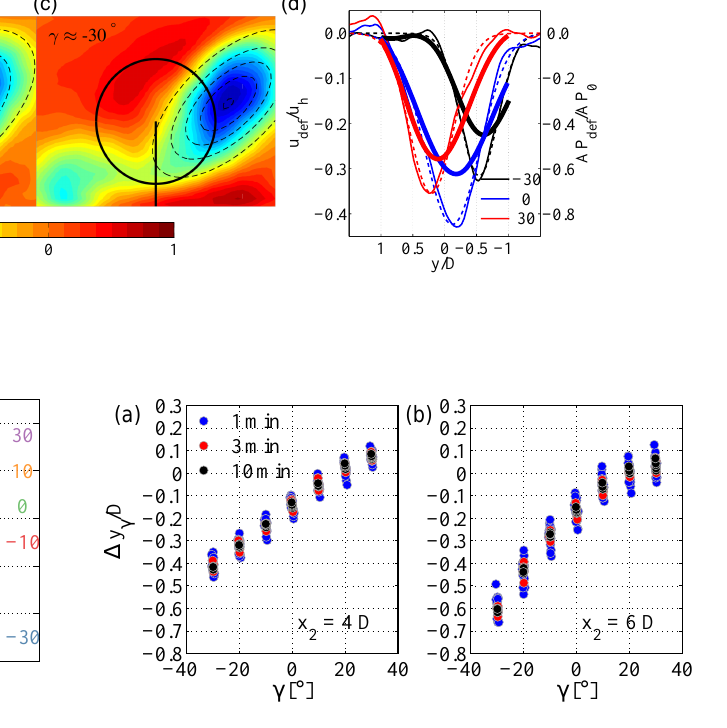
Figure 11. Same as in Fig. 8 but for the SBL